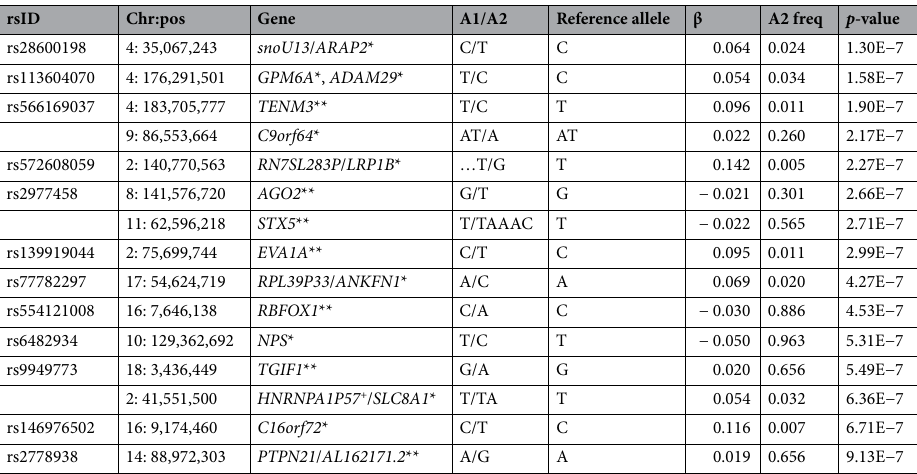
Table 4. SNPs achieving the suggestive significance ( p < 10 –6 ) for tinnitus-related distress. **Within a gene body. *Nearest gene. +